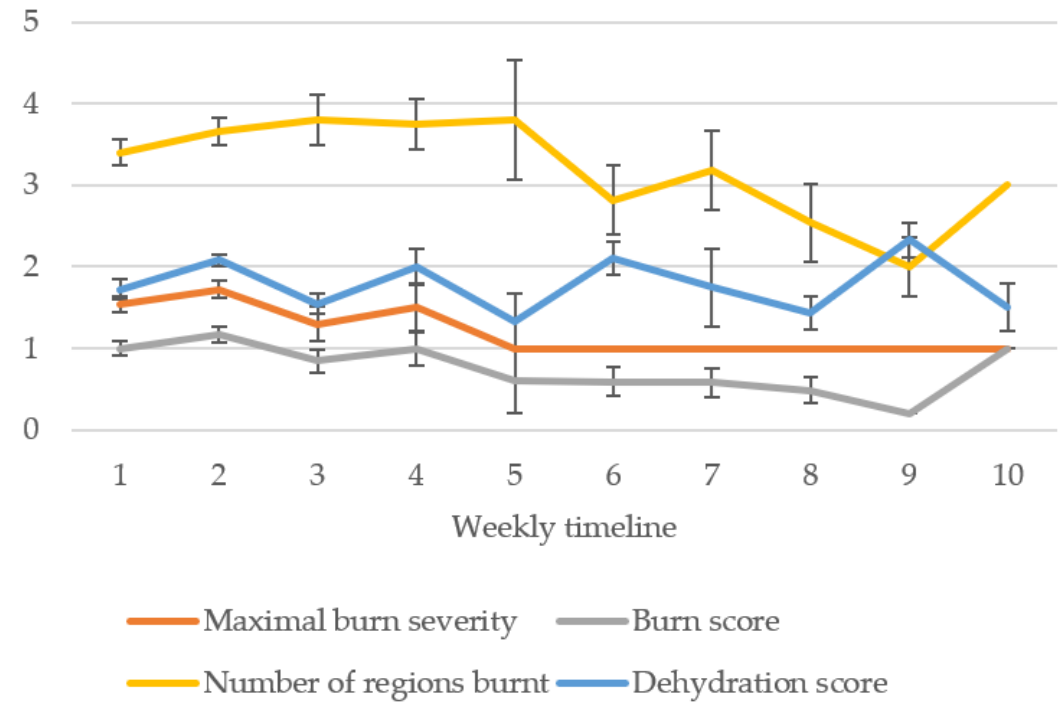
Figure 6. Weekly mean burn score (0.2–3), mean maximum burn severity (1–3), mean number of regions burnt (1–5), and mean dehydration score (1–3), for koalas assessed at triage (standard error bars shown).